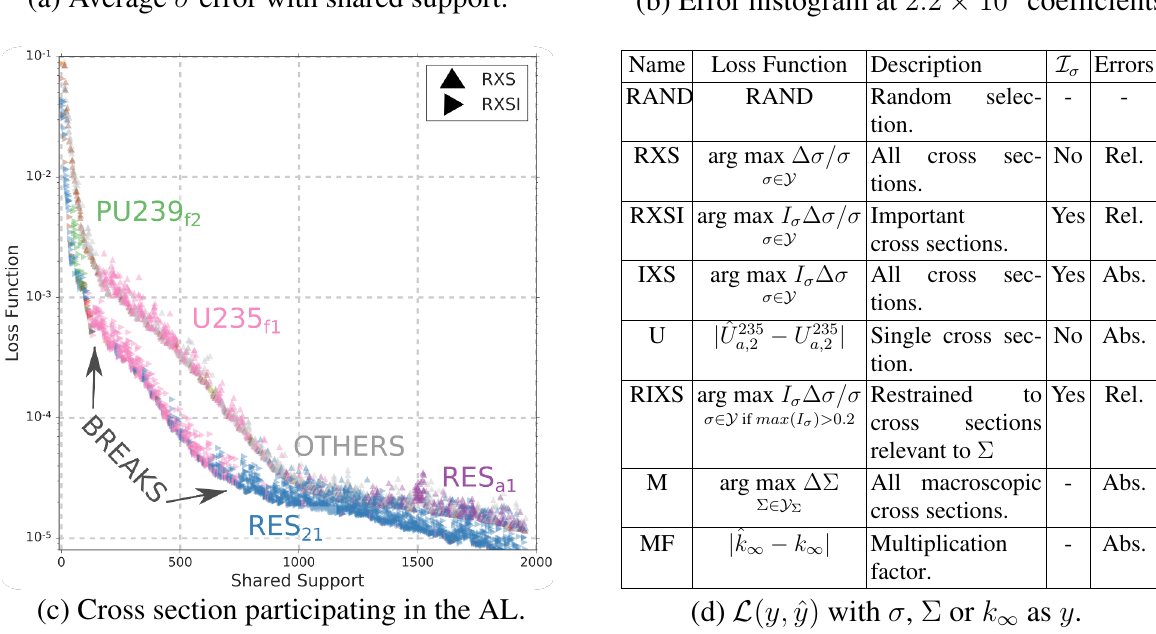
Figure 2: Cross section modeling with Kernel Methods and Active